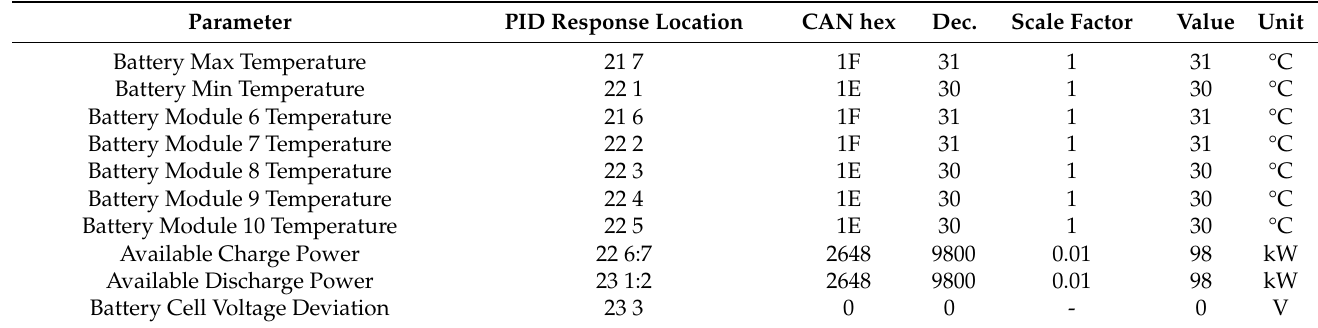
Figure 8. Processing of raw hexadecimal data response from the Hyundai Ioniq Battery Electric to the Parameter ID request, 2105. Table 3. Conversion for parameters contained in response to PID